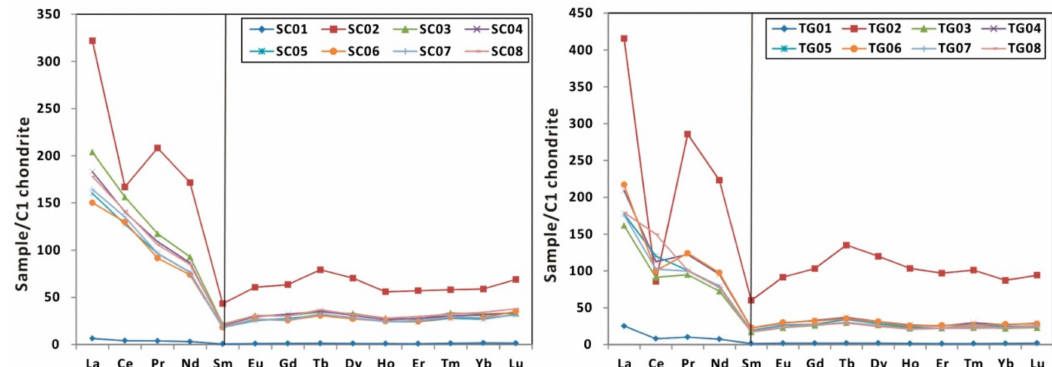
Figure5. C1Chondrite-normalizedREEpatternsofsamplesoftheSCandTGprofiles. Theconcentration was normalized to Chondrite after Taylor and Mclennan [22].